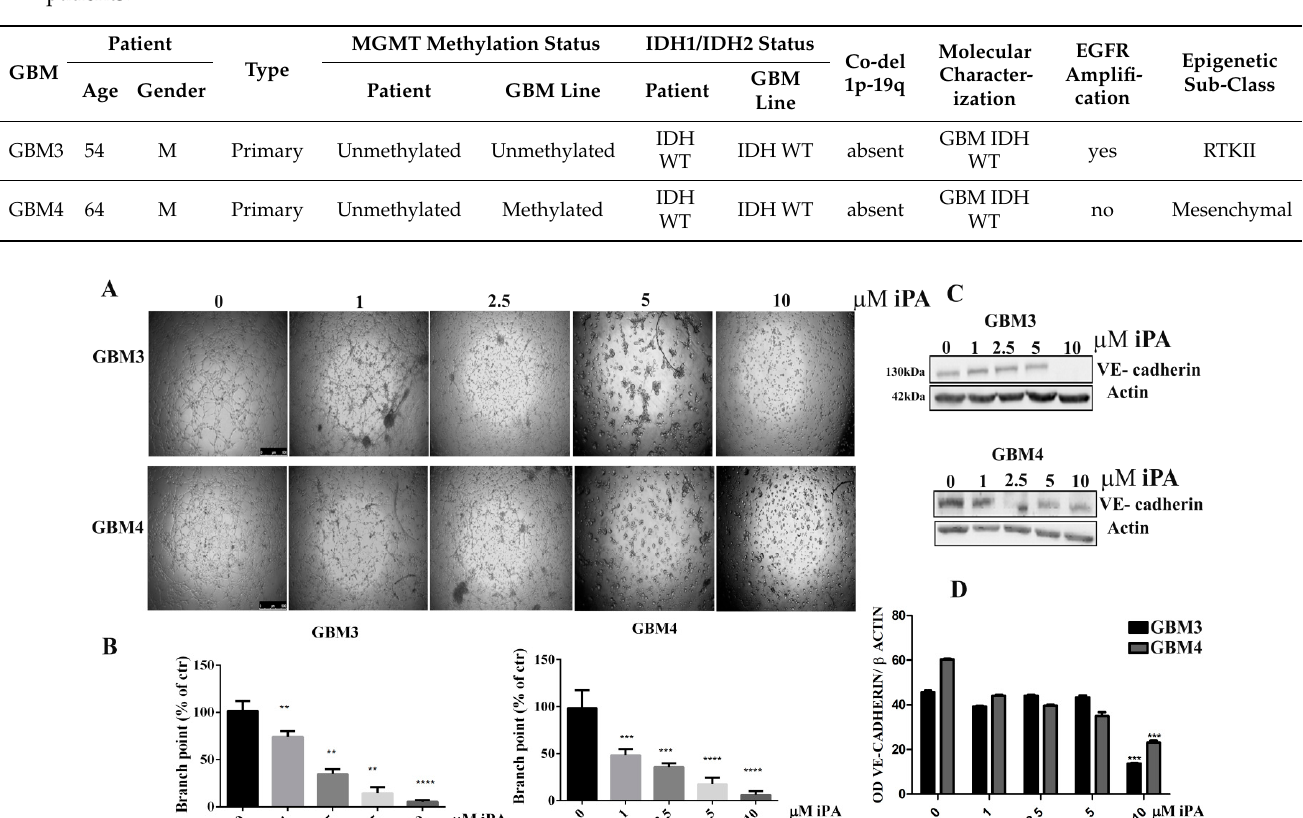
Table 1. Reassuming the genetic and epigenetic profile of GBM3 and GBM4 primary cell lines obtained from affected patients.